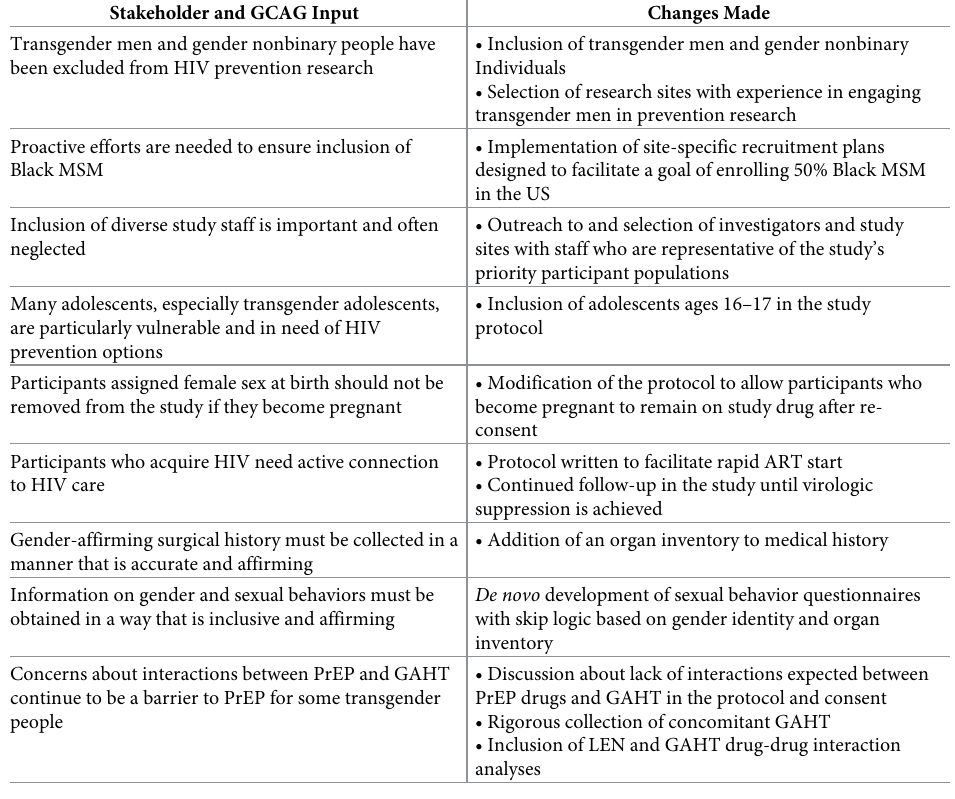
Table 1. Changes to the PURPOSE 2 study design and protocol based on stakeholder and Global Community Advisory and Accountability (GCAG) feedback. Stakeholder and GCAG